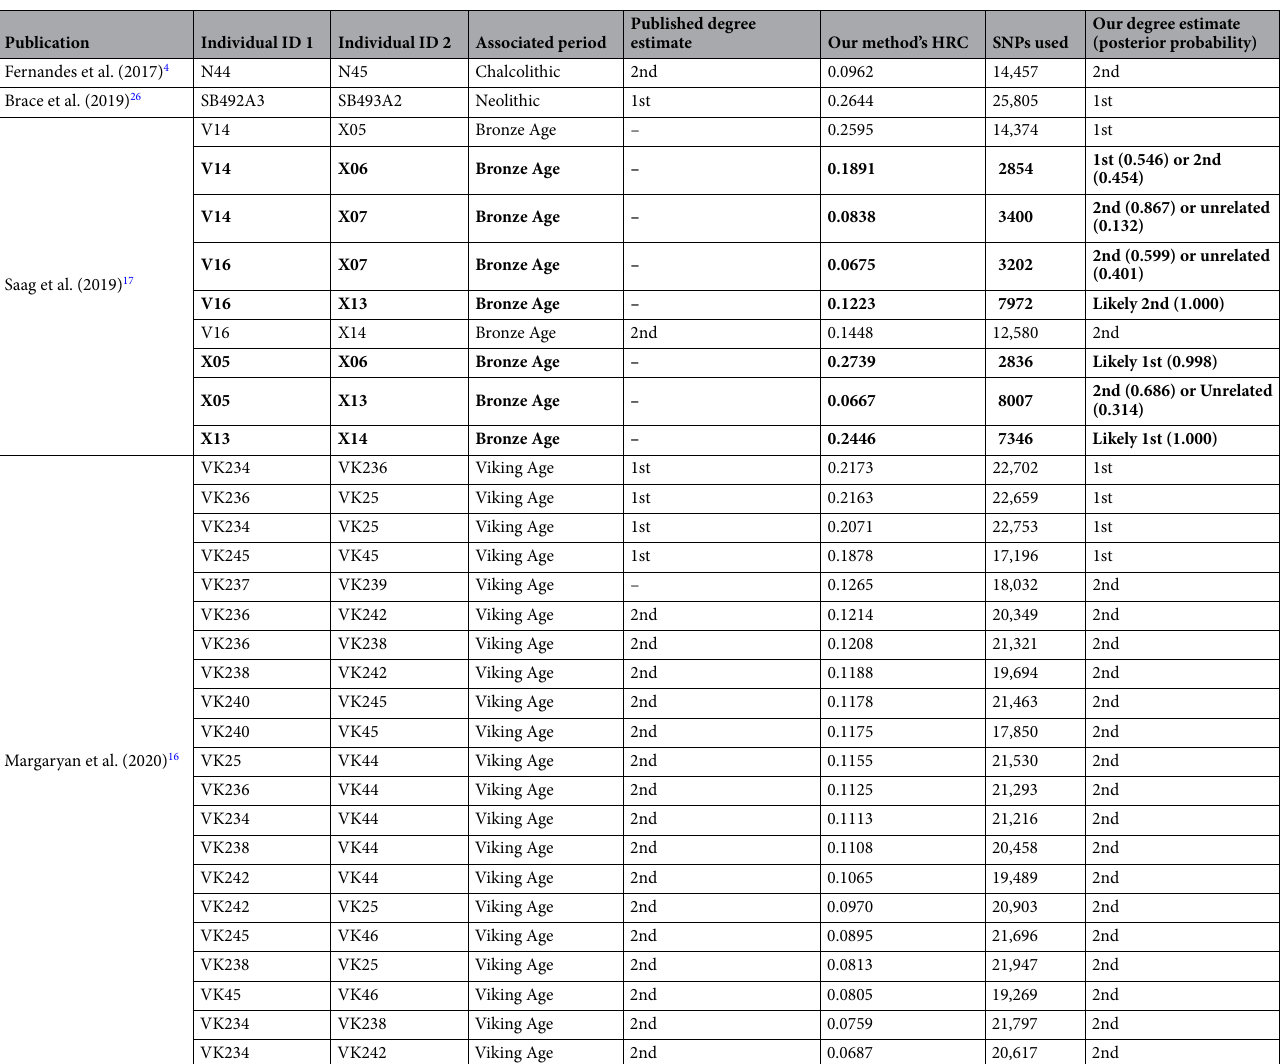
Table 1. Application of the method to other published ancient individuals. BAM files were downloaded from the European Nucleotide Database, subsampled to a maximum of 1,300,000 reads, and then processed through our pipeline. The allele frequencies used were from individuals with European ancestry in the 1000 Genomes Phase 3 dataset. Estimates in bold are based on less than 10,000 SNPs, and therefore include some degree of uncertainty. For these, we present the posterior probabilities of each degree between parentheses, and on Supplementary Figure 2 we show the corresponding simulated range plots for these